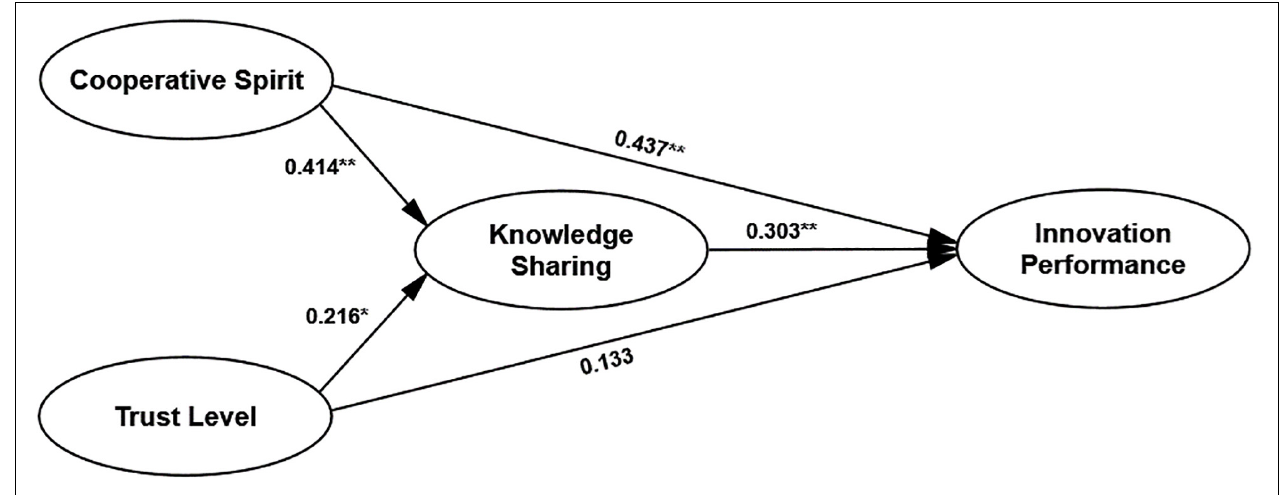
FIGURE 3 | The mediating role of alliance member knowledge sharing in the impact of membership on innovation performance. ** p < 0.01, * p < 0.05.